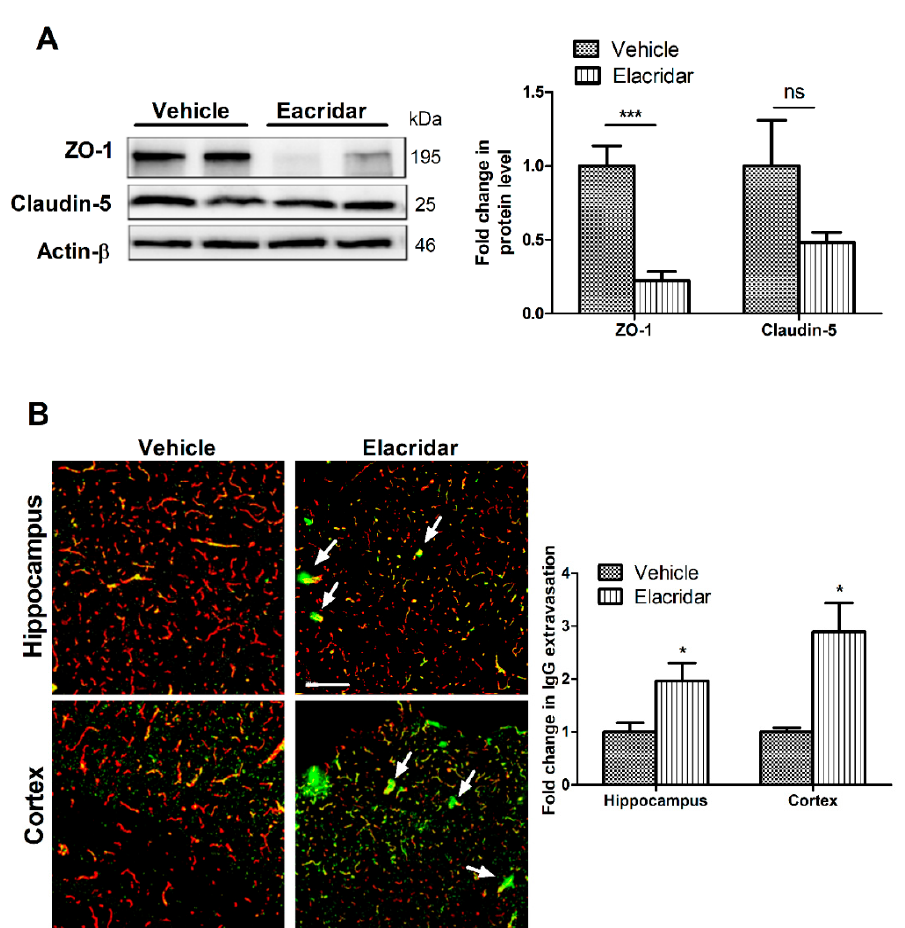
Figure 3. Treatment with elacridar (10 mg/kg) i.p. for 28 days disrupted BBB integrity in TgSwDI mice. ( A ) Representative Western blot and densitometry analysis of ZO-1 and claudin-5 in vivo from microvessels isolated from mouse brains. Elacridar treatment significantly decreased the expression of ZO1 in isolated microvessels from mouse brains when compared to the vehicle-treated group. kDa indicates the molecular weight of analyzed proteins. ( B ) Representative brain sections stained with anti-mouse IgG antibody to detect IgG extravasation (green) and anti-collagen antibody (red), with their optical density quantification in mouse brain hippocampus and cortex. White arrows indicate BBB leakage as demonstrated by IgG extravasation (green). Elacridar increased IgG extravasation in mouse hippocampus and cortex compared to vehicle-treated mice. Scale bar = 100 µm. Statistical analysis was determined by Student’s t -test. Data represented as mean ± SEM of n = 5 mice per group. ns = not significant; * p < 0.05, *** p < 0.001 compared to vehicle.